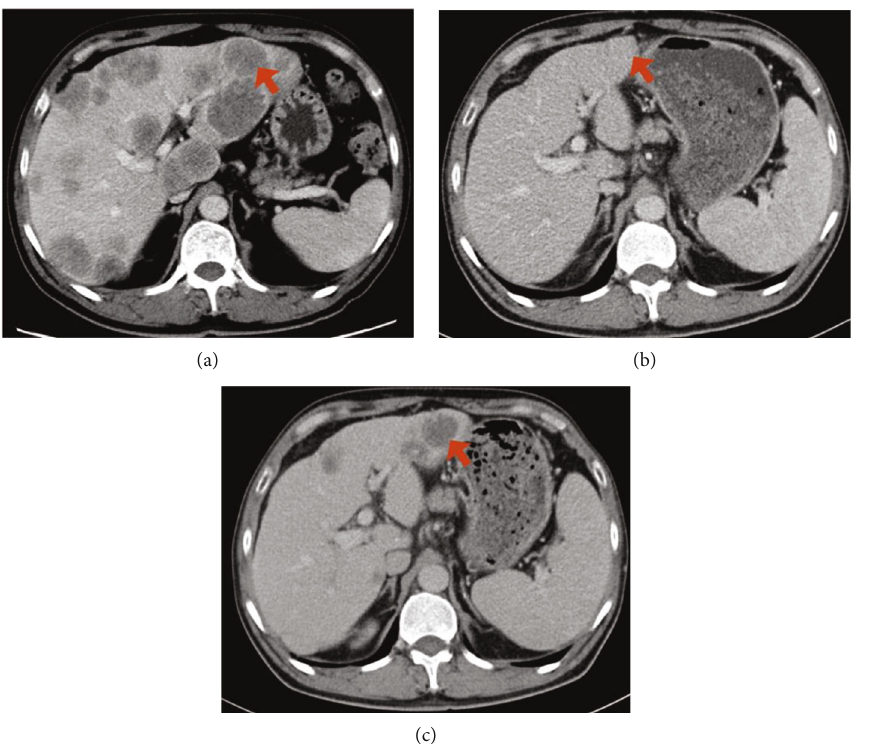
Figure 2: Examples of DLM on preoperative image in patients with CRLM. (a) Image showing the CRLM in the fi rst diagnosis time (arrow). (b) Image showing DLM after conversion therapy (arrow). (c) Image showing recurrence of DLM with follow-up (arrow). Abbreviations: CRLM: colorectal liver metastases; DLM: disappearing liver metastasis; MRI: magnetic resonance